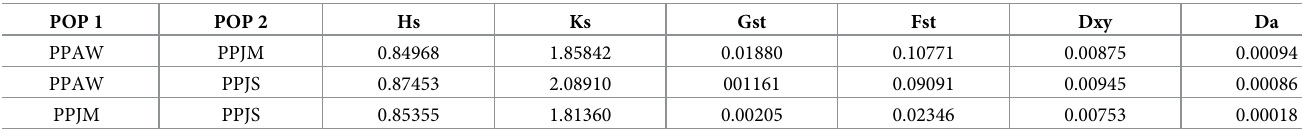
analysis revealed great genetic differentiation between Aswan, Egypt, and Malka, Jordan with an Fst value of 0.10913 and moderate genetic differentiation between Aswan, Egypt, and Swai- meh, Jordan with a value of 0.06936 (Table 9). There is little genetic differentiation between Malka, Jordan, and Swaimeh, Jordan, (Fst = 0.01595). The median joining network for PpSP28 similarly does not exhibit any clear clustering of the Egypt or Jordan populations, however there are as many as 11 mutations separating connected haplotypes (Fig 9). PpSP28 sliding window analysis of Ka/Ks demonstrates the potential for PpSP28 to be under diversifying selection in several areas in contrast to the majority of the protein under purifying selection in all populations (Table 10). Values higher than one were detected in all 3 populations with PPJM having two sliding window regions with values over one compared to one sliding win- dow region in PPJS and PPAW (Table 10). Table 6. PpSP14 pairwise comparisons of genetic differentiation